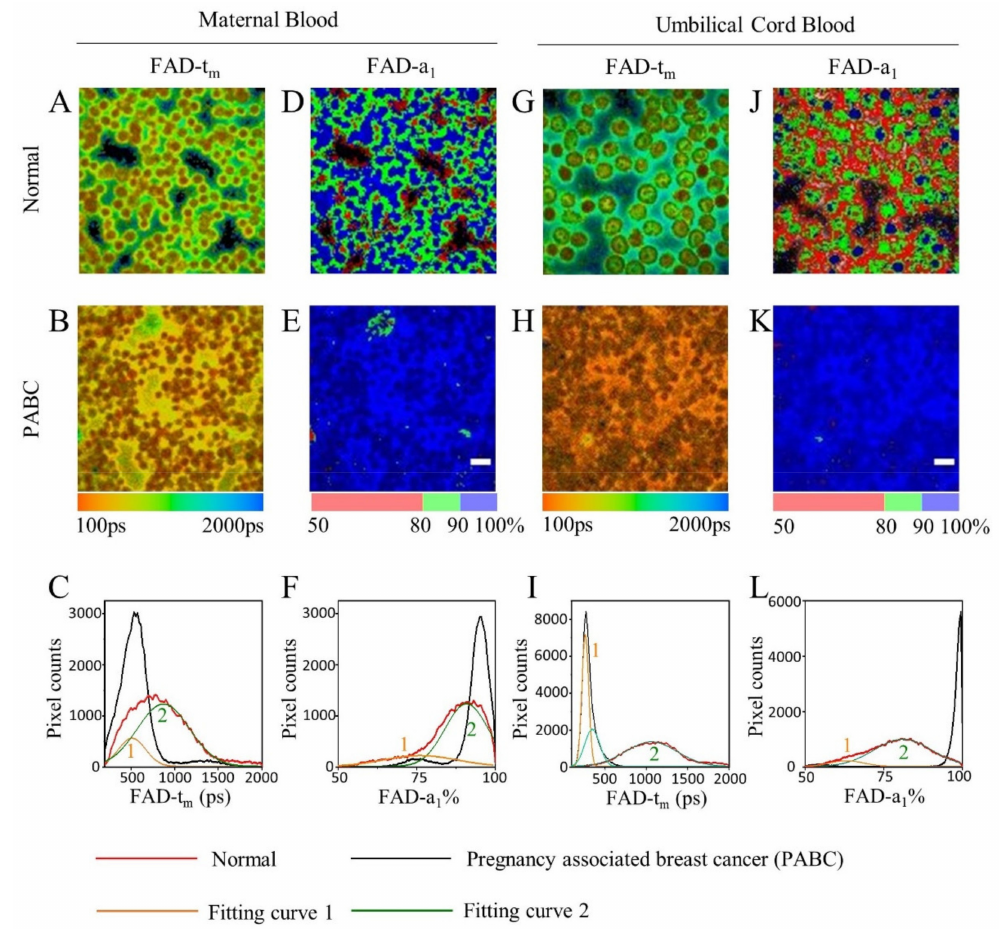
Figure 4. Representative FAD FLIM images and their distribution curves of PABC and normal cases. ( A , B , D , E ) t m and a 1 images of maternal blood, ( G , H , J , K ) t m and a 1 images of umbilical cord blood. ( C , F , I , L ) Distribution curves of corresponding images. Scale bar: 10 µ